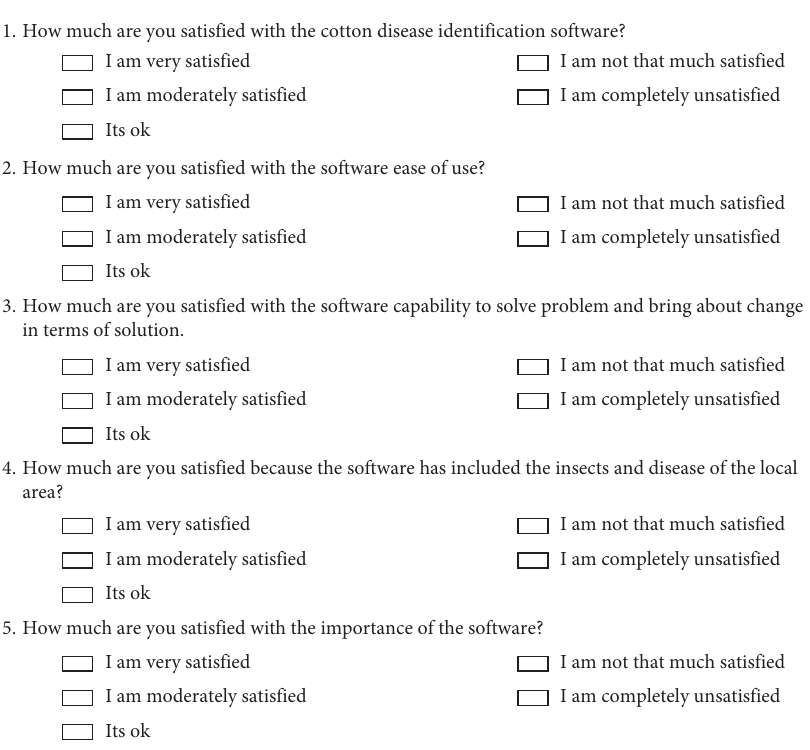
Figure 11: Prototype evaluation questionnaire are distributed to Ethiopian cotton farm experts. Table 1: Model performance evaluation result.